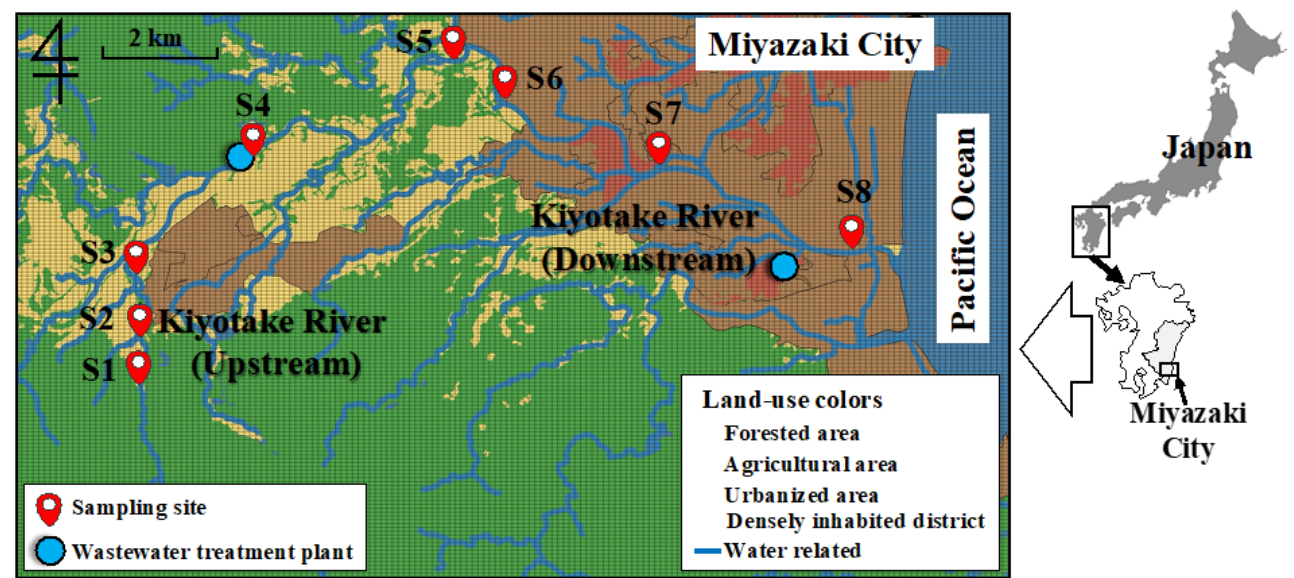
Figure 1. Sampling sites in the Kiyotake River watershed. Land-use patterns (urbanized area, densely inhabited district, forest area, and agricultural area) and the location of wastewater treatment plants are also shown.